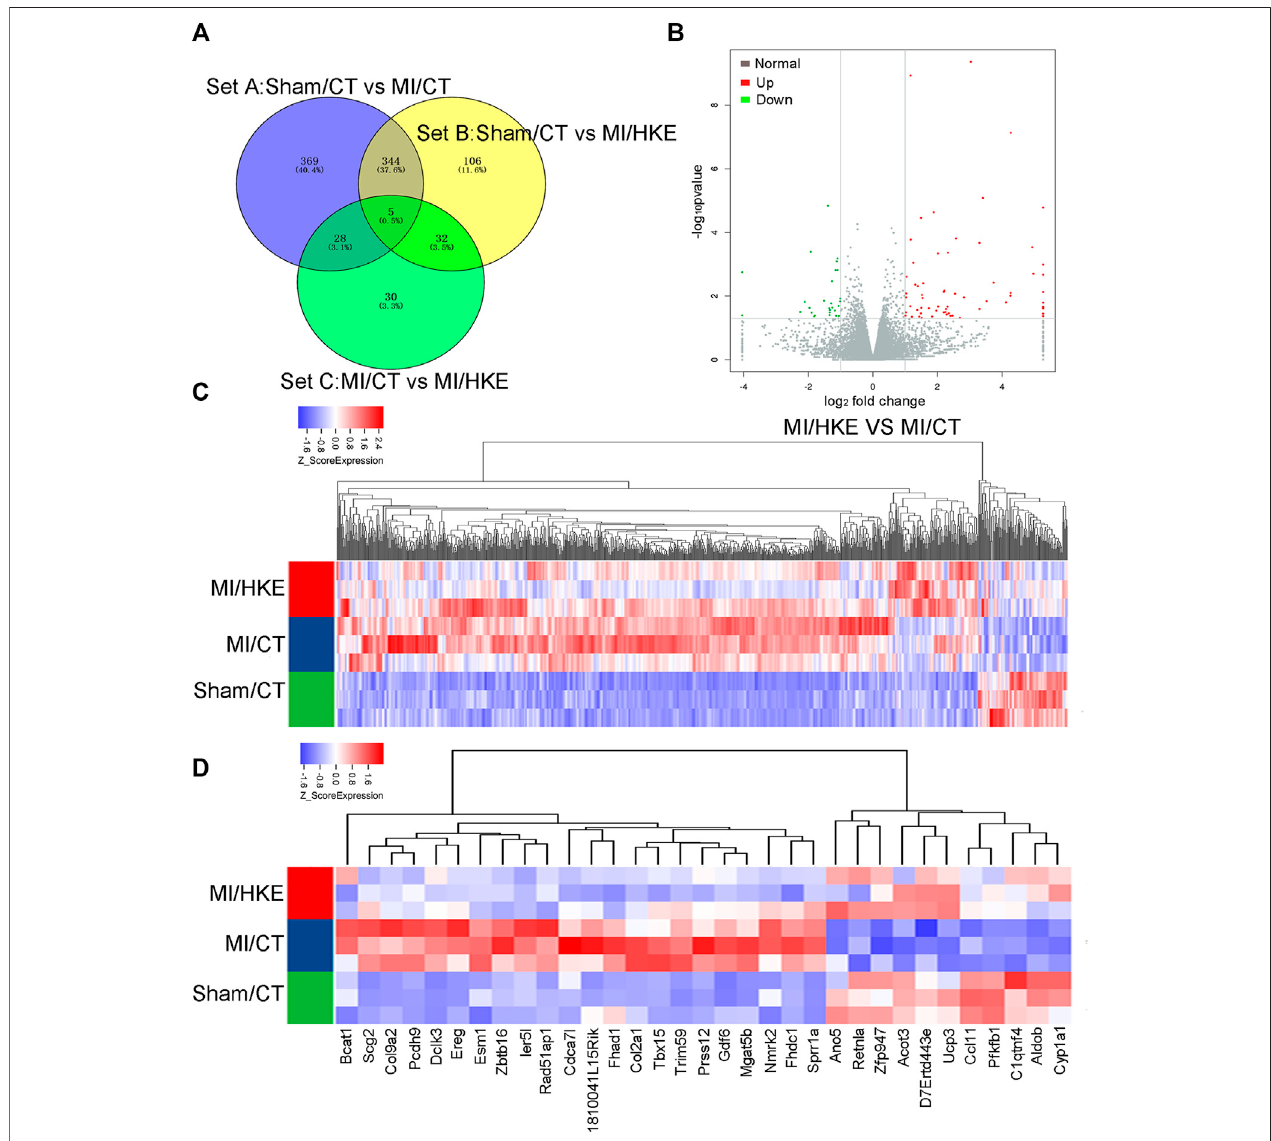
FIGURE4| RNAseqanddifferentialgeneexpressionanalysis.TotalRNAwasisolatedfromhearttissueforRNAseq( n =3pergroup).Thedifferentexpressedgene numbersbetweeneachgroupwereshownbyVenndiagram (A) .ThevolcanoplotshowsthedifferentexpressedgenesbetweenMI/CTandMI/HKE (B) .Clusteranalysis of all differential genes (C) . Cluster analysis of 33 differential genes in the intersection of Set A and Set C (D) .